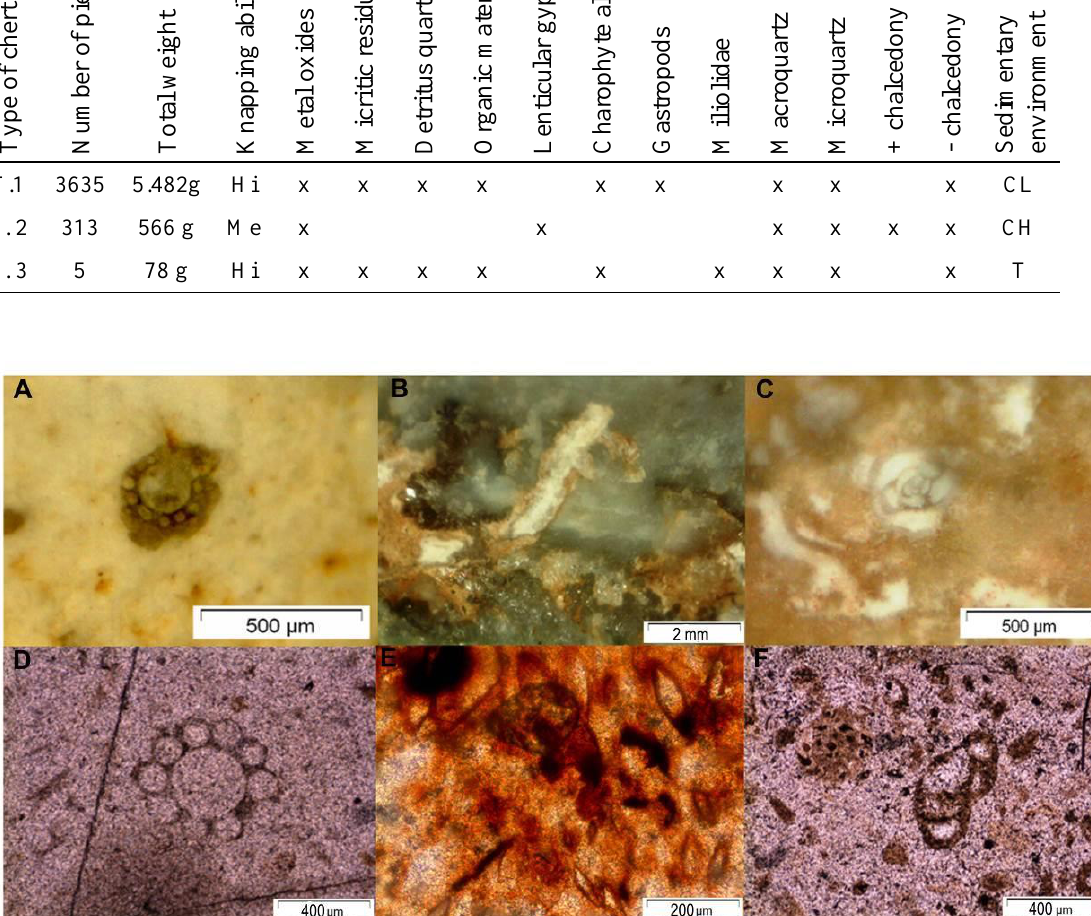
Figure 4. Main characteristics of each group. Type 1 (A and D): Charophyte algae ; Type 2 (B and E): B – Recrystallizations and E – Lenticular gypsum pseudomorphs; Type 3 (C and F): Miliolidae . Images A to C are macroscopical view and images D to F are crossed polarised views. See below for further